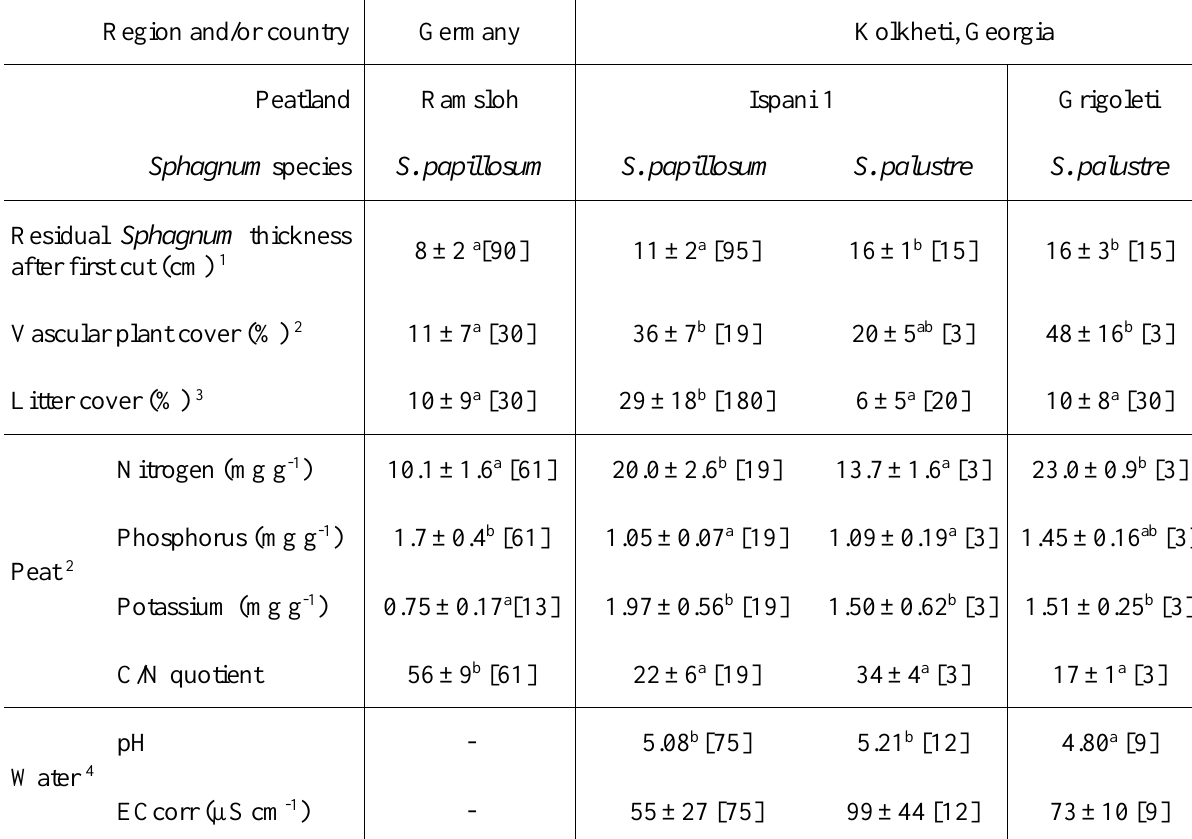
Table A3. Site conditions (mean values with standard deviation) of different peatlands and Sphagnum species over the periods Aug 2008–Mar 2011 (Ramsloh), Apr 2007–Mar 2009 (Ispani 1) and Apr 2008–Mar 2009 (Grigoleti). Number of measurements is shown in square brackets and is based on number of plots ( n = 19 for S. papillosum at Ispani 1 and n = 3 for S. palustre at Ispani 1, S. palustre at Grigoleti and S. papillosum at Ramsloh) and frequency of sampling ( 1 5 times per plot in Kolkheti and 30 times per plot at Ramsloh; 2 once per plot, except peat chemistry measurements in Germany, see text for details; 3 ten sampling squares per plot, fewer for damaged plots; 4 three times per plot for one-year cutting interval and six times for two-year cutting interval in Kolkheti, S. papillosum : [13 plots × 3 measurements] + [6 × 6] = 75 and S. palustre : [2 × 3] + [1 × 6] = 12). Differences from the numbers initially installed are due to removal of damaged plots from the analysis. Statistical significance of differences in site conditions (indicated by different superscripted letters) was tested with the non-parametric Kruskal Wallis test after Siegel & Castellan (1988), following a significant overall Kruskal Wallis test for each variable ( P -value < 0.001) - Residual Sphagnum thickness: χ 2 = 42.96; Vascular plant cover: χ 2 = 42.35; Litter cover: χ 2 = 77.16; Nitrogen (peat): χ 2 = 53.57; Phosphorus (peat): χ 2 =